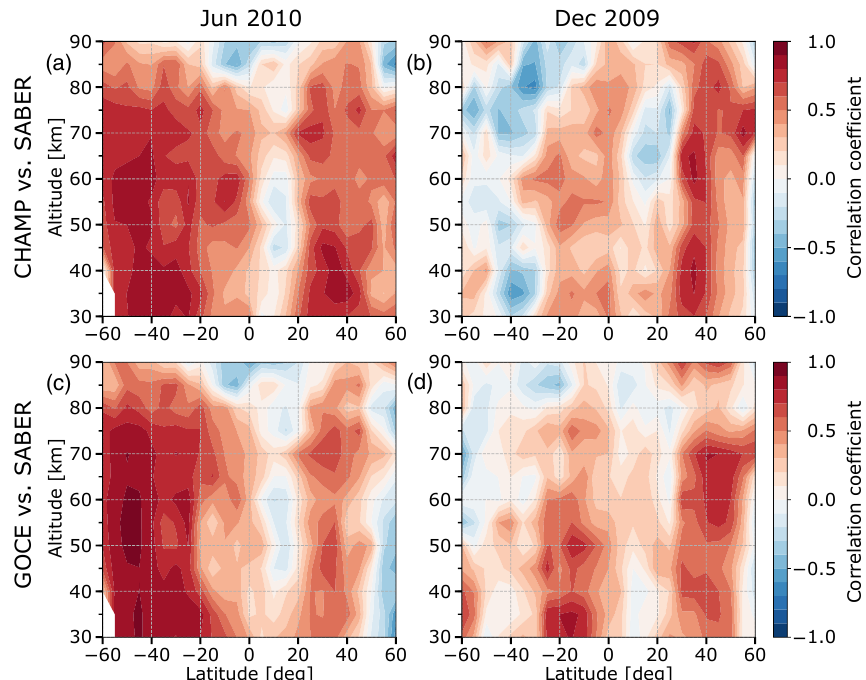
Figure 7. Correlations between (a, b) CHAMP ARDF and SABER GWMF and (c, d) GOCE ARDF and SABER GWMF for (a, c) boreal summer and (b, d) austral summer. In June 2010 (a, c) the two satellites were at almost the same altitude, while in December 2009 (b, d) CHAMP was at a higher altitude (310km) than GOCE